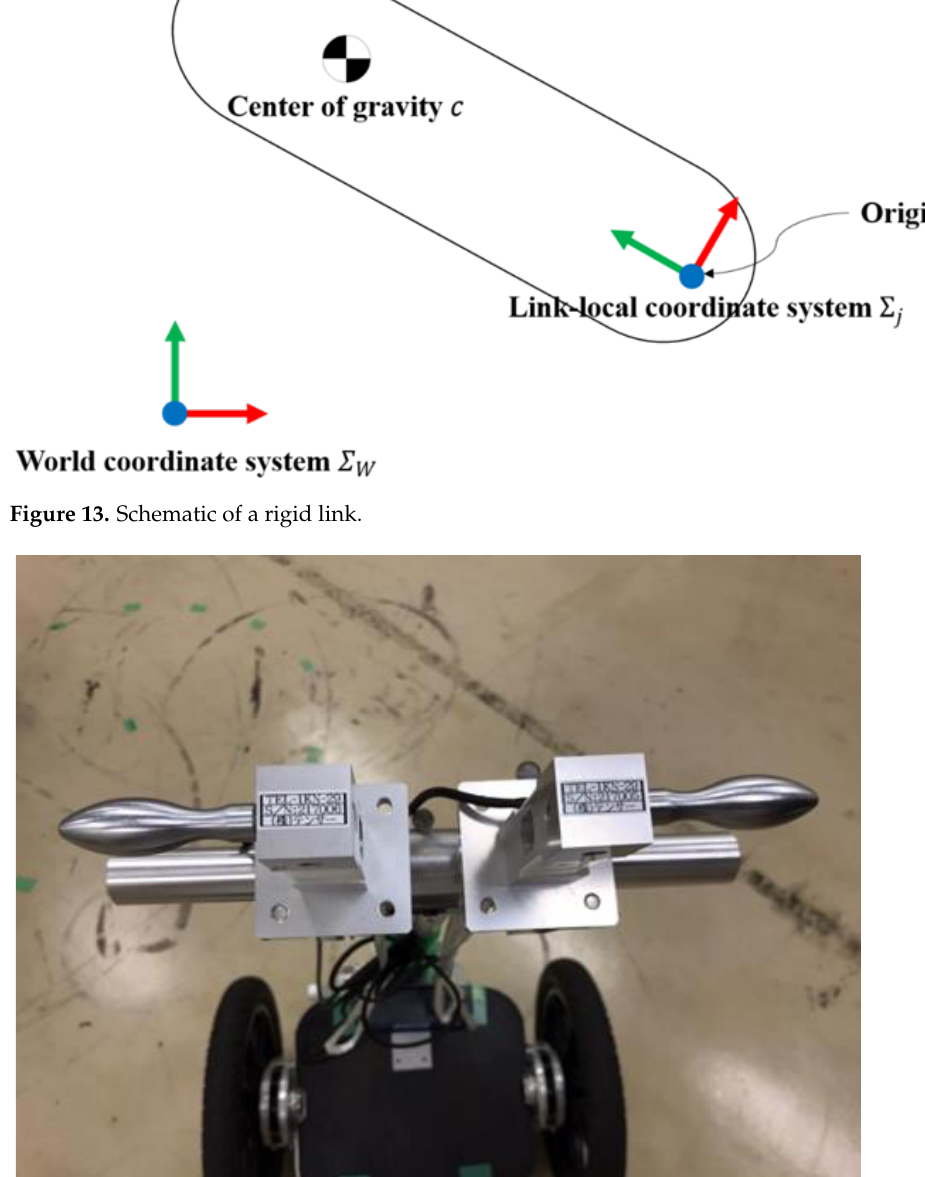
Figure 14. Handle reaction force